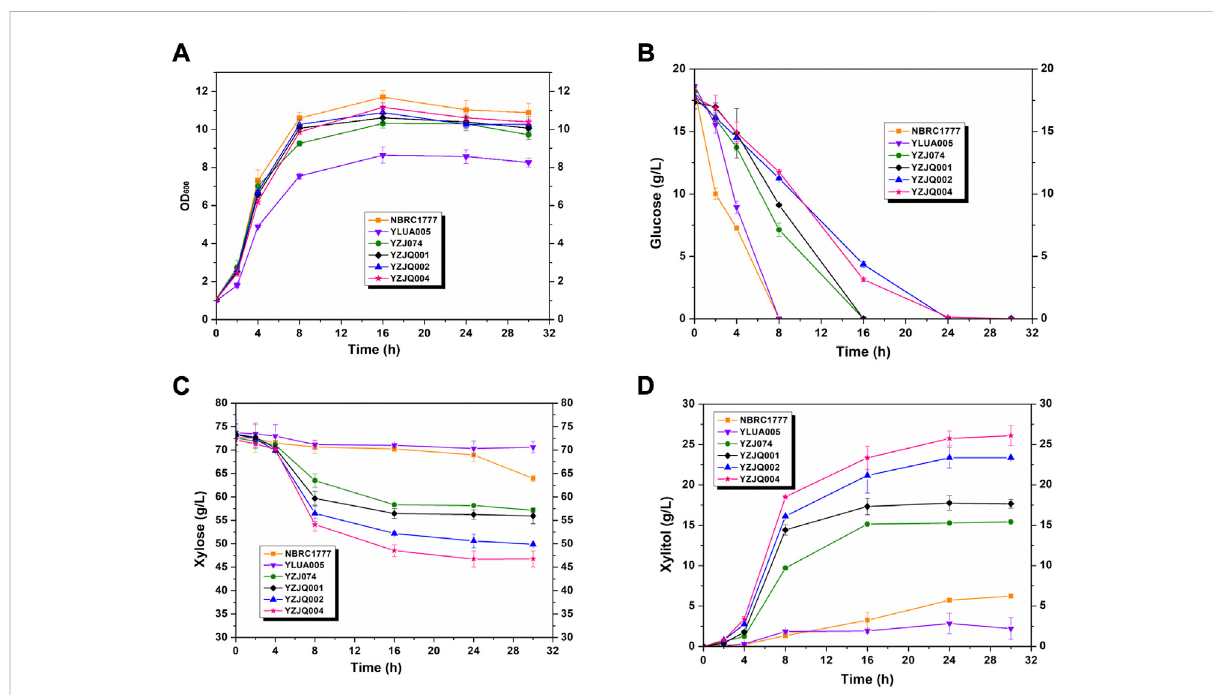
FIGURE 4 The glucose – xylose co-fermentation ability was improved by overexpression of ScGAL2-N376F. The OD600 (A) , glucose (B) , and xylose (C) consumptionandxylitol (D) productionofdifferentstrainswithvariousgenesfermentedwithYPmediumcontainingabout80 g/Lxyloseand20 g/L glucose at 42 ° C. The values are the means of three biological replicates ± standard deviation ( n = 3) at each of the time